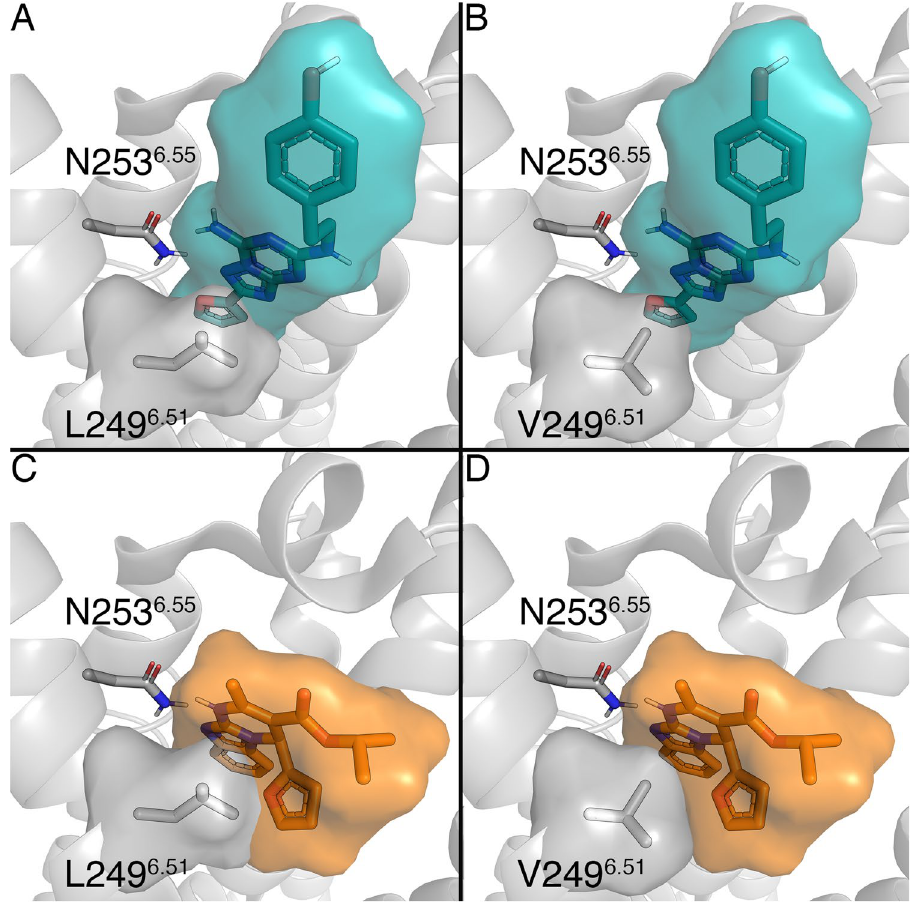
Figure 2. Binding mode of two ligands, ZM241385 (in blue, panels A and B) and ( S )-ISAM-140 (orange, panels C and D), to the WT (panels A and C) and the L249V 6.51 mutant (panels B and D) A 2A AR. Volumetric occupancies are shown as surface. Figure created with Pymol